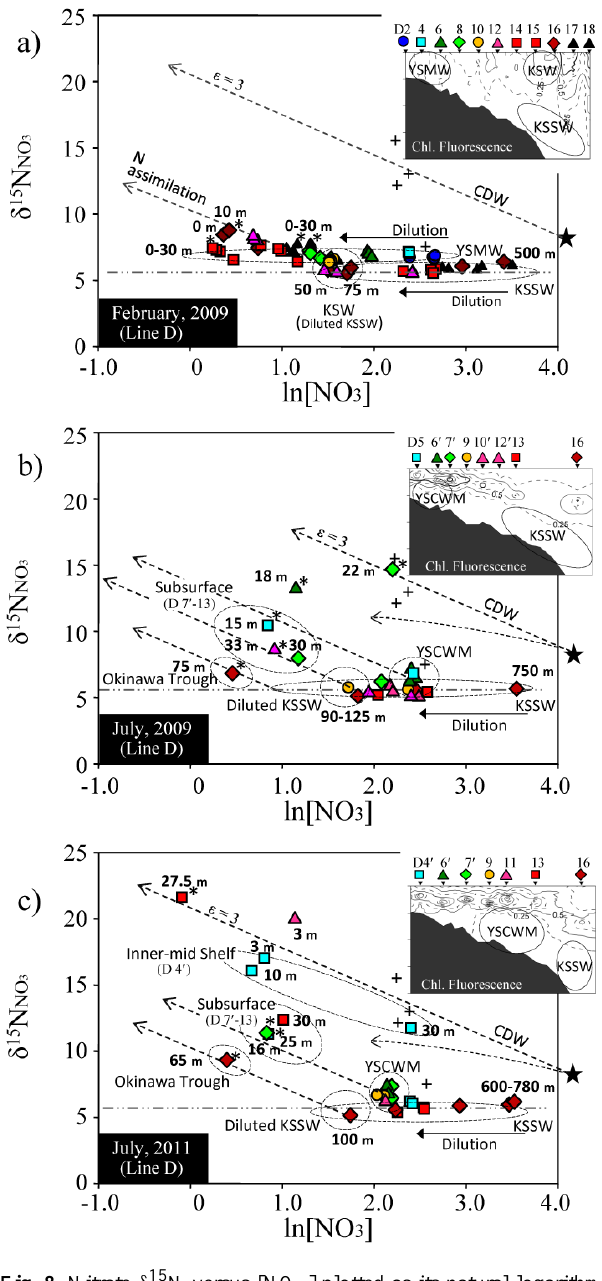
Fig. 8. Nitrate δ 15 N versus [NO 3 ] plotted as its natural logarithm for the samples collected at each location along transect D in (a) February 2009, (b) July 2009, and (c) July 2011. The numerical values near the symbols indicate water depth at locations where wa- ter was sampled, and other symbols are as those in Fig. 4. The cross symbols are δ 15 N NO –ln[NO 3 ] collected in the Changjiang Estuary 3 and adjacent ECS, where active phytoplankton uptake was observed (Chen et al., 2013). The dotted straight lines and a curved line in- dicate the expected shift in δ 15 N associated with NO 3 assimilation following the Rayleigh model ( ε = 3 . 0) and the steady-state model ( ε = 3 . 0), respectively (see Fig. 10). The two-dot chain line indi- cates the δ 15 N NO of the deep KSSW. 3